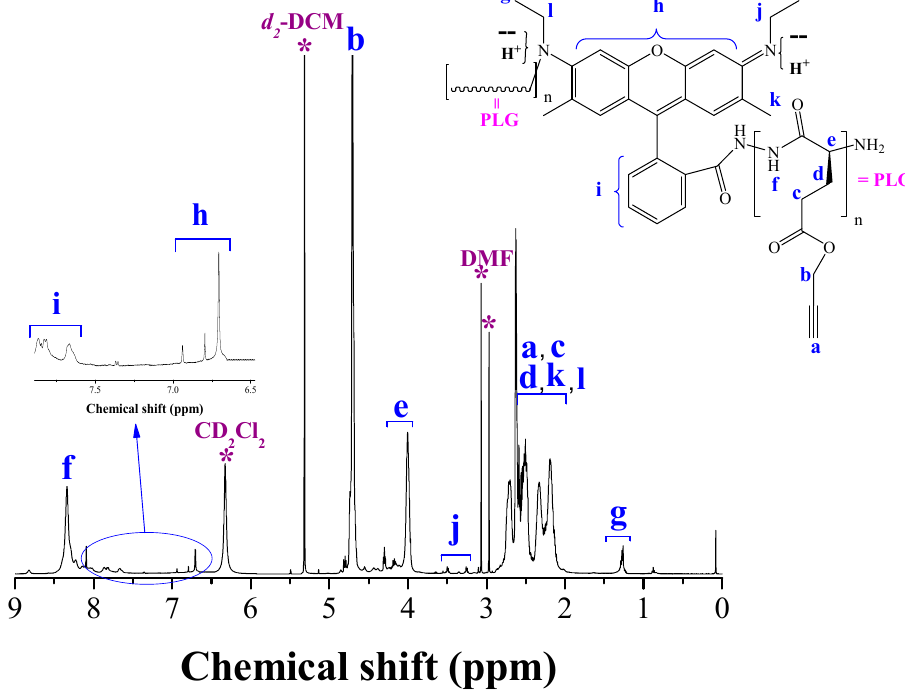
Figure 3. 1 H NMR spectrum of R–PLG 23 in CD 2 Cl 2 /TFA (trace).